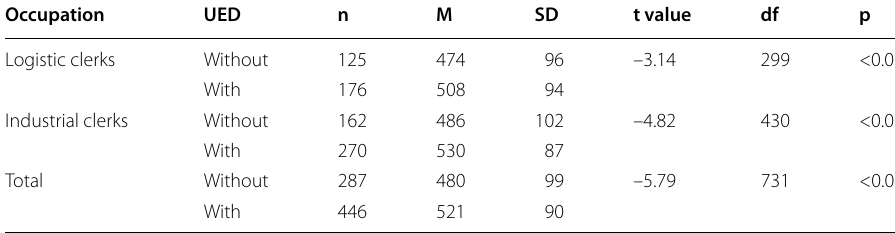
Table 4 Competence scores of German trainees with and without a UED by occupation